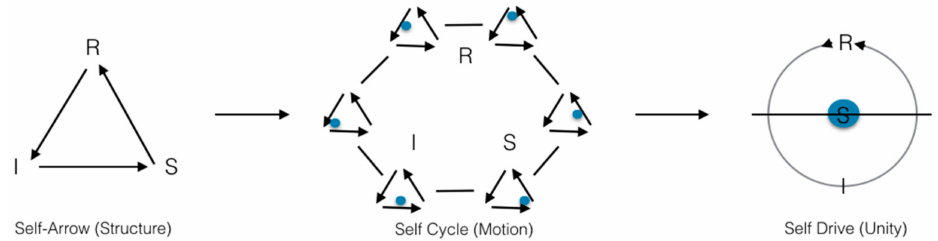
Figure 9. Structural transformations on the transcendental horizon: not-One. In the higher orders of Self we find a Unity in the not-One where the Real of openness and incompletion is fundamental to the Self’s internal Unity. The inner discovery of this Unity shifts the subject from a mode of pure desire to pure drive. In the mode of pure drive the gap/difference the Imaginary detects in the Real produces a Symbolic rotary motion of pure enjoyment (ideal-real) where desire is